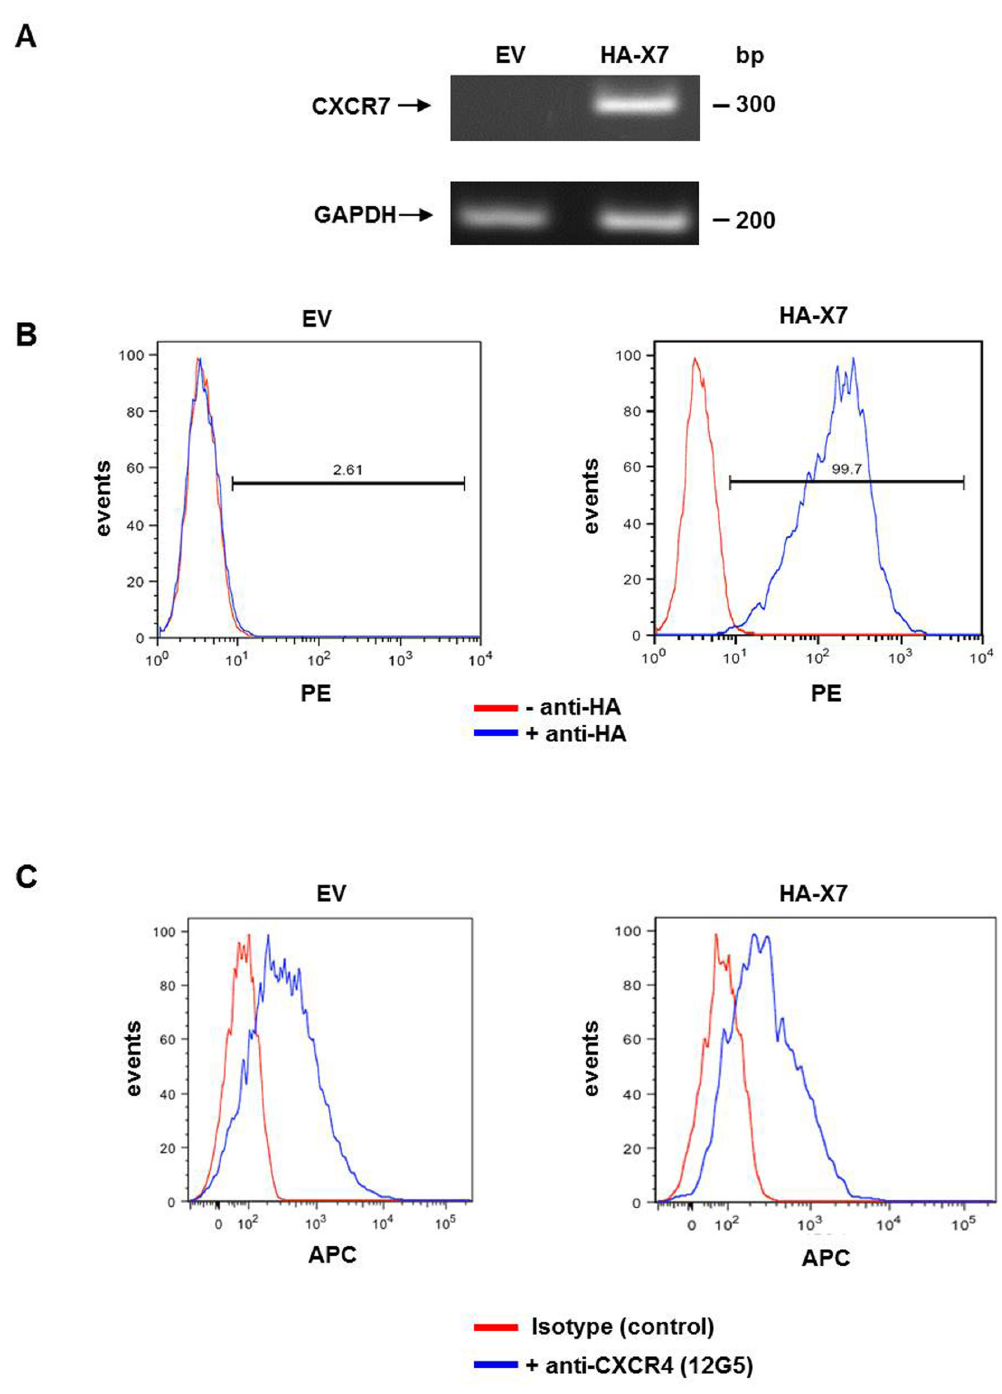
Figure 1. Overexpression of HA-CXCR7 in human OS 143B- LacZ cells. (A) Semi-quantitative RT-PCR analysis showed non- detectable expression of CXCR7 in 143B- LacZ -EV (EV) cells and abundant HA-CXCR7 (HA-X7) expression in 143B- LacZ -HA-X7 cells. GAPDH was used as reference gene. (B) FACS analysis showed HA-CXCR7 cell surface expression in HA-immunostained (blue profiles) 143B- LacZ -HA-X7 cells, which was not observed in 143B- LacZ -EV (EV) cells. Red profiles were obtained in the absence of HA antibody (n≥3). (C) FACS analysis with 12G5 antibody showed comparable CXCR4 surface expression in 143B- LacZ -EV and 143B- LacZ -HA-X7 cells (blue profiles), confirming that the overexpression of CXCR7 did not alter the endogenous levels of CXCR4. Red profiles indicate cells that were analyzed in the absence of 12G5 antibody (n=2). doi: 10.1371/journal.pone.0074045.g001 PLOS ONE |